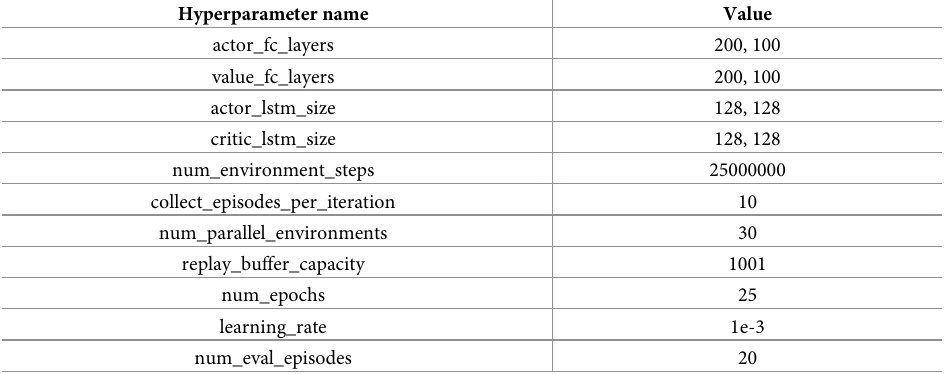
Table 2. Hyperparameters for